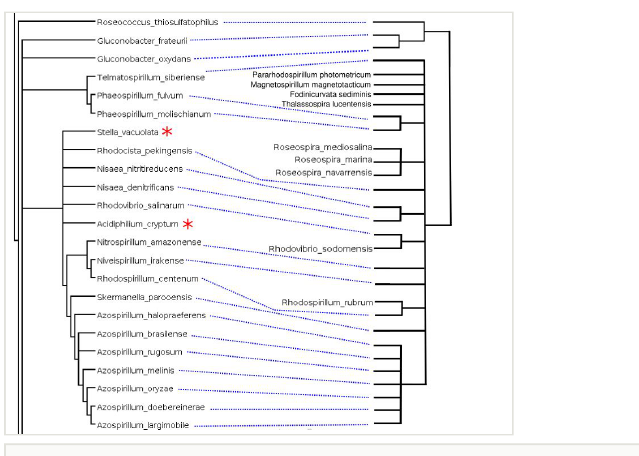
Figure 7. Comparison between our supertree (left) and the NCBI Taxonomy reference tree (right) : This example section of the supertree corresponds to taxa mostly from Rhodospirillaceae with the exception of rogue taxa indicated with a red asterisk. This section is related to the NCBI taxonomy reference tree on the right, containing those Rhodospirillaceae species leaves included in the supertree analysis (27). Nine taxa out of the 27 Rhodospirillaceae included were reconstructed elsewhere in our supertree (not shown). This is representative of the phylogenetic placement errors found throughout the supertree: individual rogue taxa, as well as misplaced clades of related